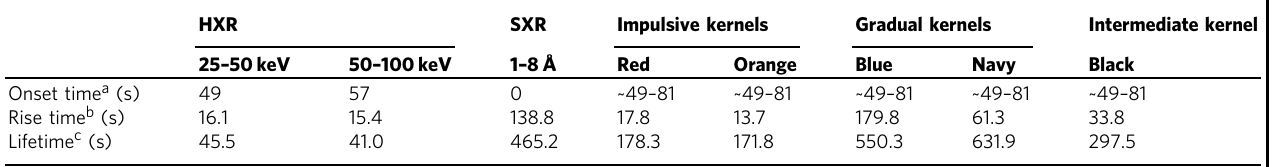
a De fi ned as the elapsed time from the onset time of the SXR emission at 03:19:39UT b De fi ned as the time interval from 1/ e to the peak contrast c De fi ned as the time interval from 1/ e of the peak contrast in the rising phase to that in the decay